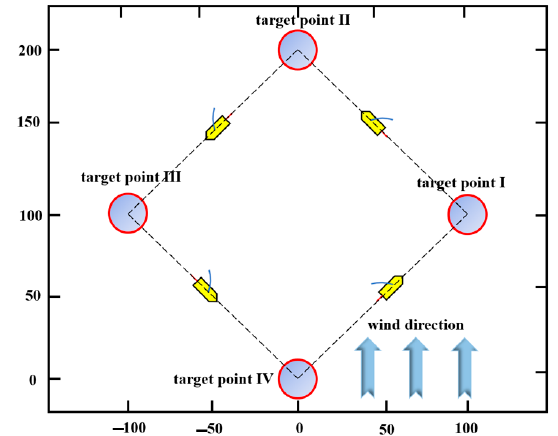
Figure 10. Schematic diagram of four-point navigation.